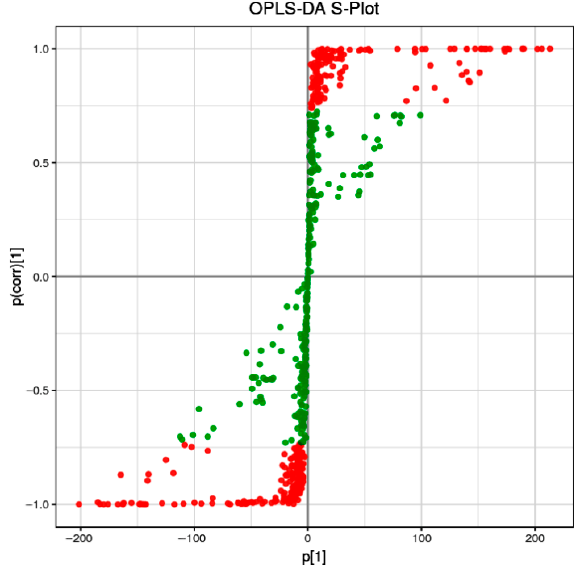
Figure 1. OPLS ‐ DA S ‐ plot of RG versus PL samples. Each point represents a metabolite, red color Figure 1. OPLS-DA S-plot of RG versus PL samples. Each point represents a metabolite, red color indicates metabolites with VIP ≥ 1, green indicates metabolites with VIP < 1. indicates metabolites with VIP ≥ 1, green indicates metabolites with VIP < 1.